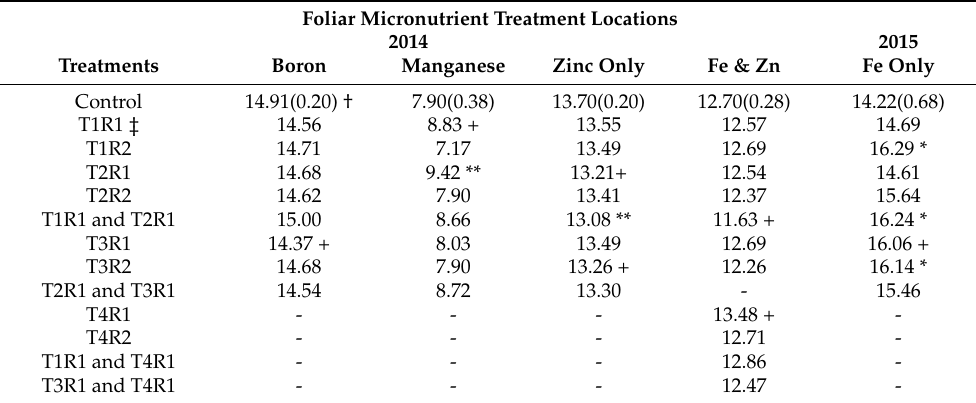
Table 3. Multiple comparison test of LSmean yields (Mg ha − 1 ) comparing foliar-applied micronutrient treatment effects applied at different rates and growth stages with the control using Dunnett’s